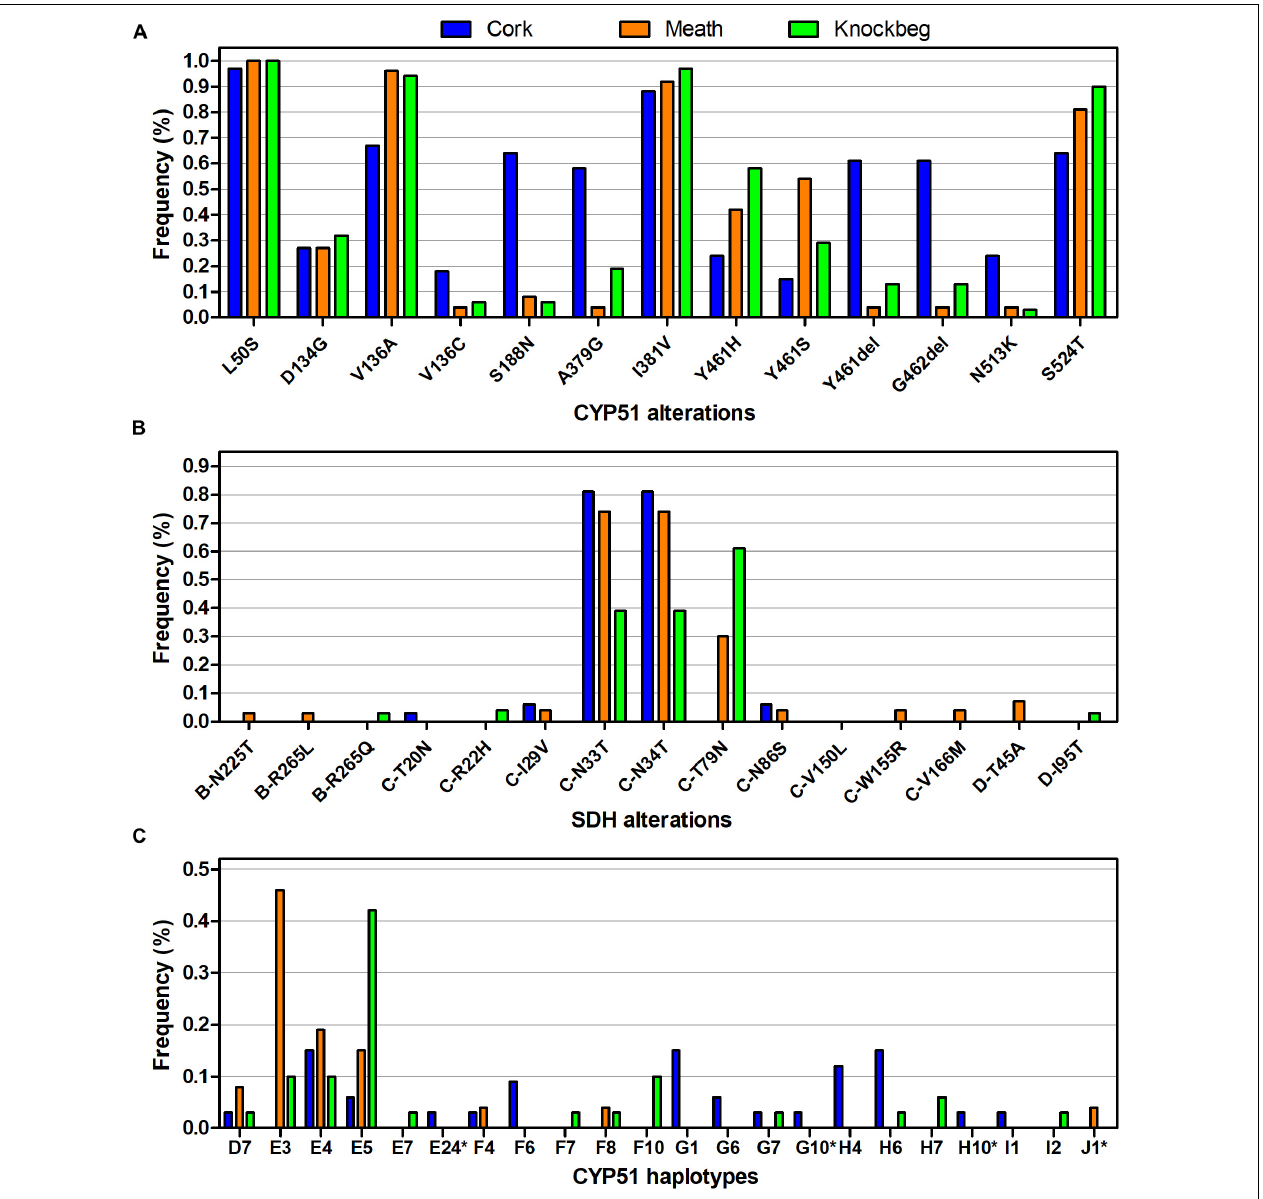
FIGURE 2 | Differences in frequencies of the different (A) SdhB , C , and D alterations, (B) CYP51 amino acids, and (C) CYP51 amino acid haplotypes between the three sites sampled. CYP51 haplotypes as described by Huf et al. (2018), except those marked with asterisk (*), which represents new combinations of amino acid